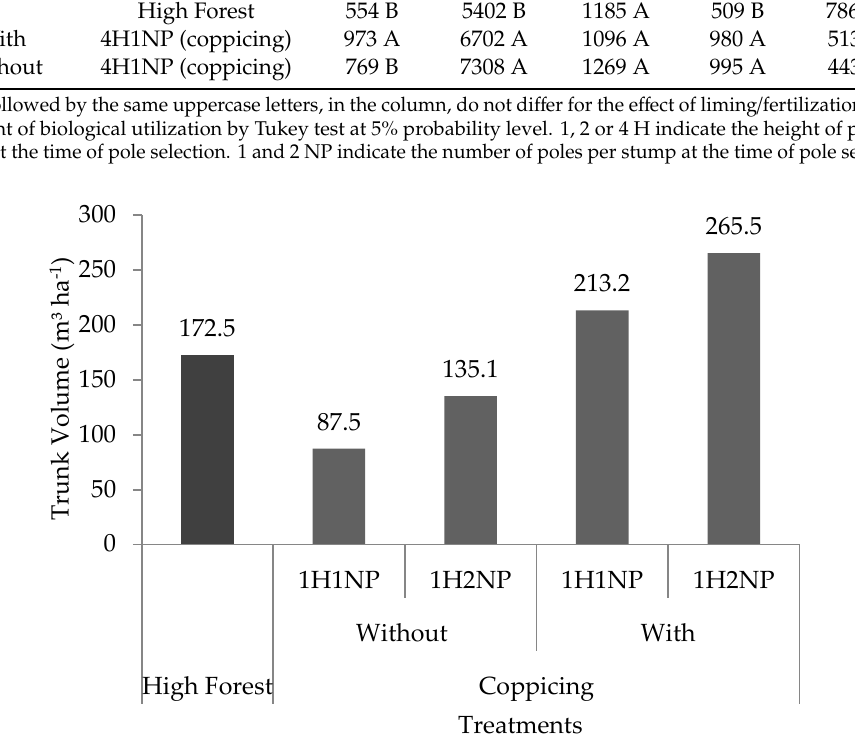
Figure 4. Trunk volume of the high-forest system as compared to that with and without liming/fertilization of the coppicing system (corrected by the survival rate of each treatment). 1, 2 or 4 H indicate the height of poles, in meters, at the time of pole selection. 1 and 2 NP indicate the number of poles per stump at the time of pole selection.